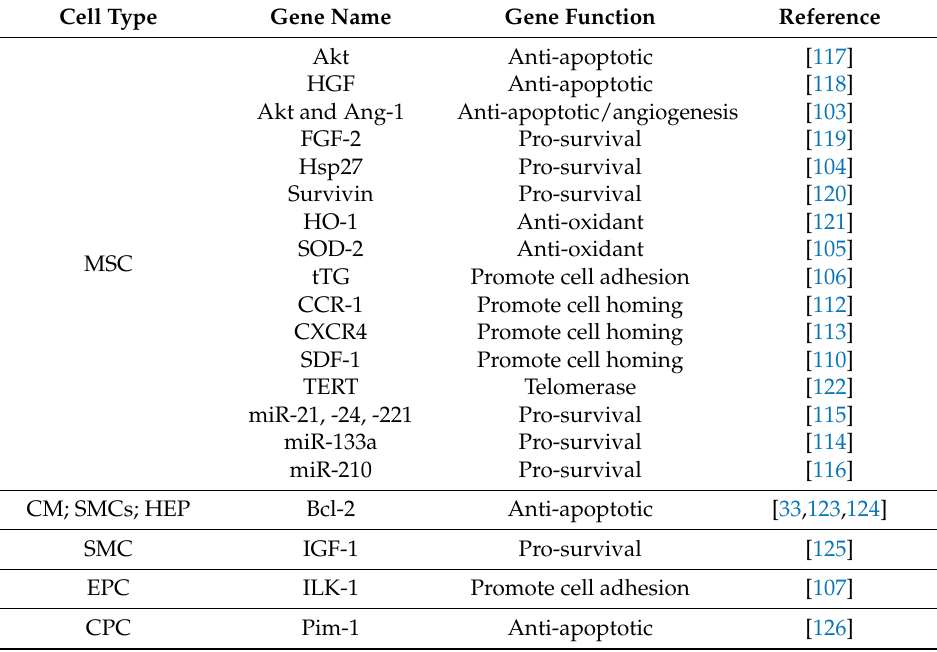
Table 3. Genetic engineering